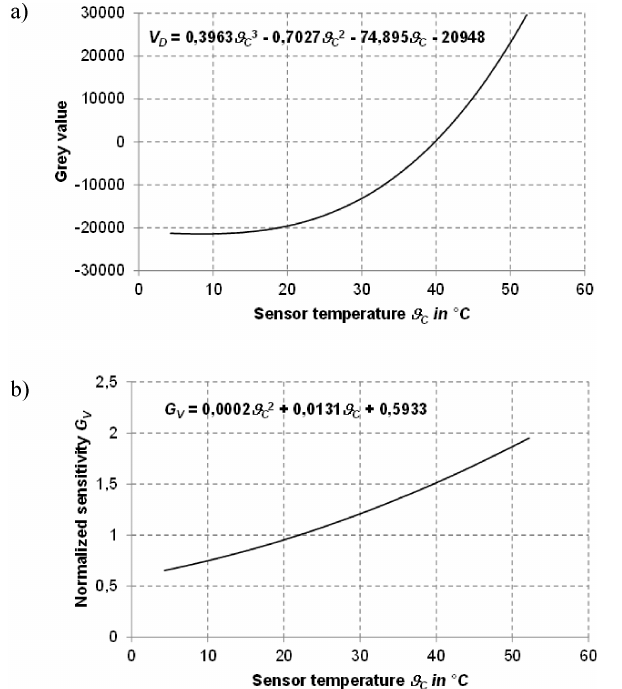
Figure 12. Temperature dependence of (a) the offset values and (b) the sensitivity of the observed TEC-less microbolometer arrays. The coefficients allow for a physical interpretation. The